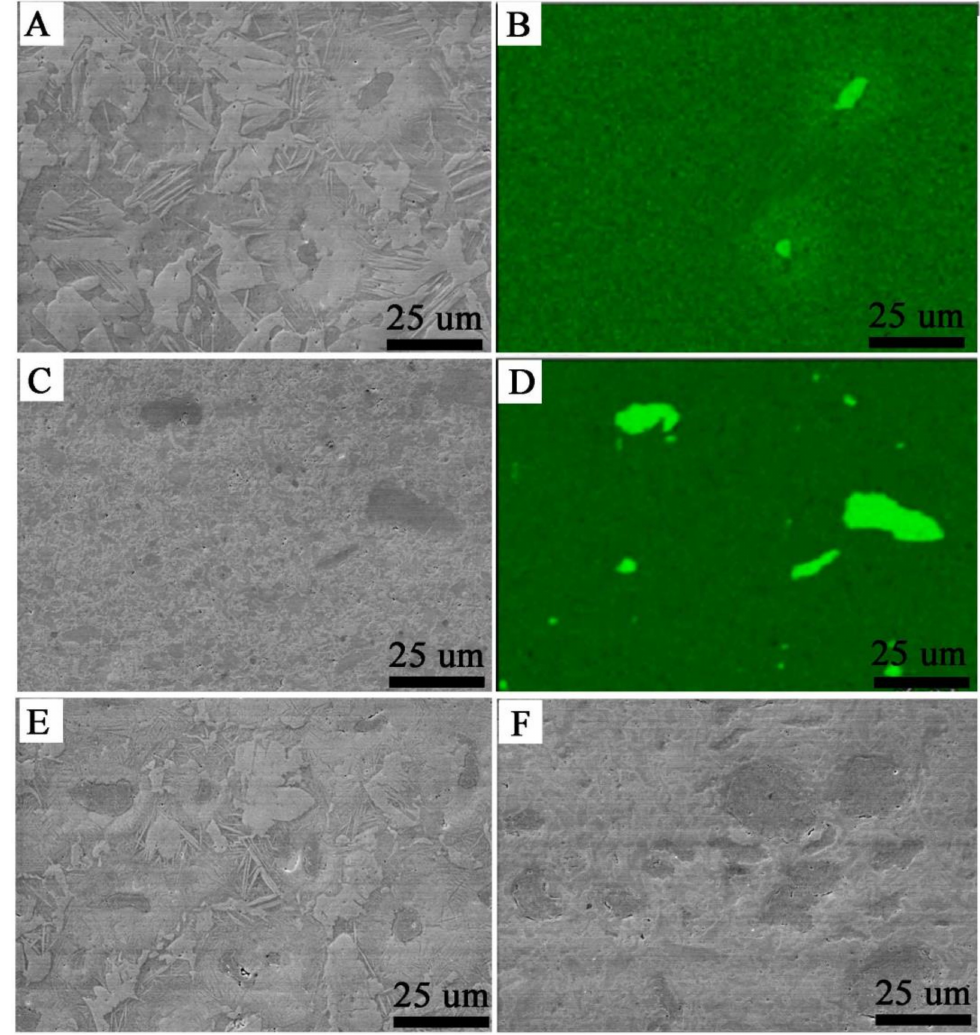
Figure 3. Microstructures of the SPS Zr-2.5 mass% Nb, SEM ( A ); SPS Zr-2.5 mass% Nb, the niobium distribution, EDS ( B ); KOBO-extruded Zr-2.5 mass% Nb, SEM ( C ); KOBO-extruded Zr-2.5 mass% Nb, the niobium distribution, EDS ( D ); the SPS Zr-16 mass% Nb, SEM ( E ); KOBO-extruded Zr-16 mass% Nb, SEM ( F